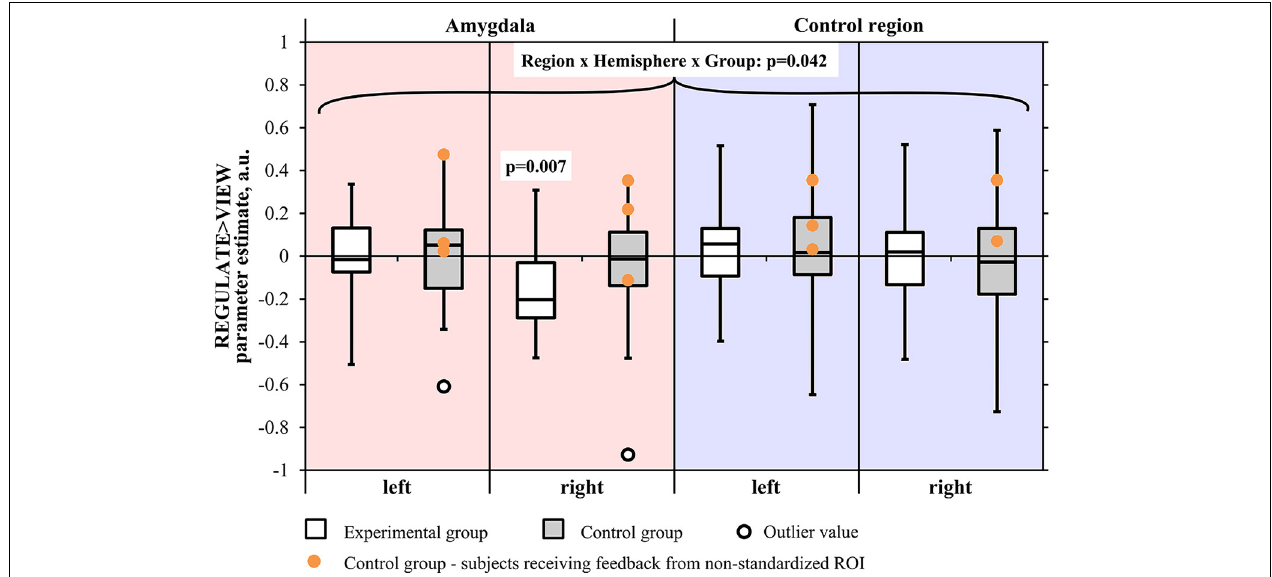
FIGURE 4 | Results of the region-of-interest analysis of the transfer run. Negative values indicate a decrease of the BOLD signal amplitude in the regulate condition (REGULATE) compared to natural responding toward aversive pictures (VIEW). White box plots: participants receiving feedback from the amygdala during training (experimental group). Gray box plots: participants receiving feedback from a standardized control region during